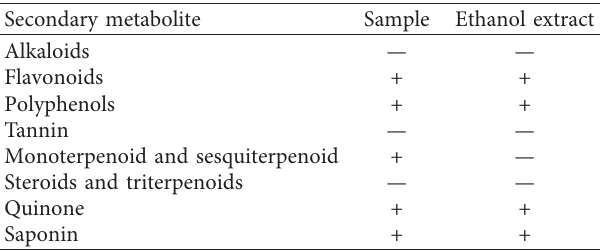
extract of cassava